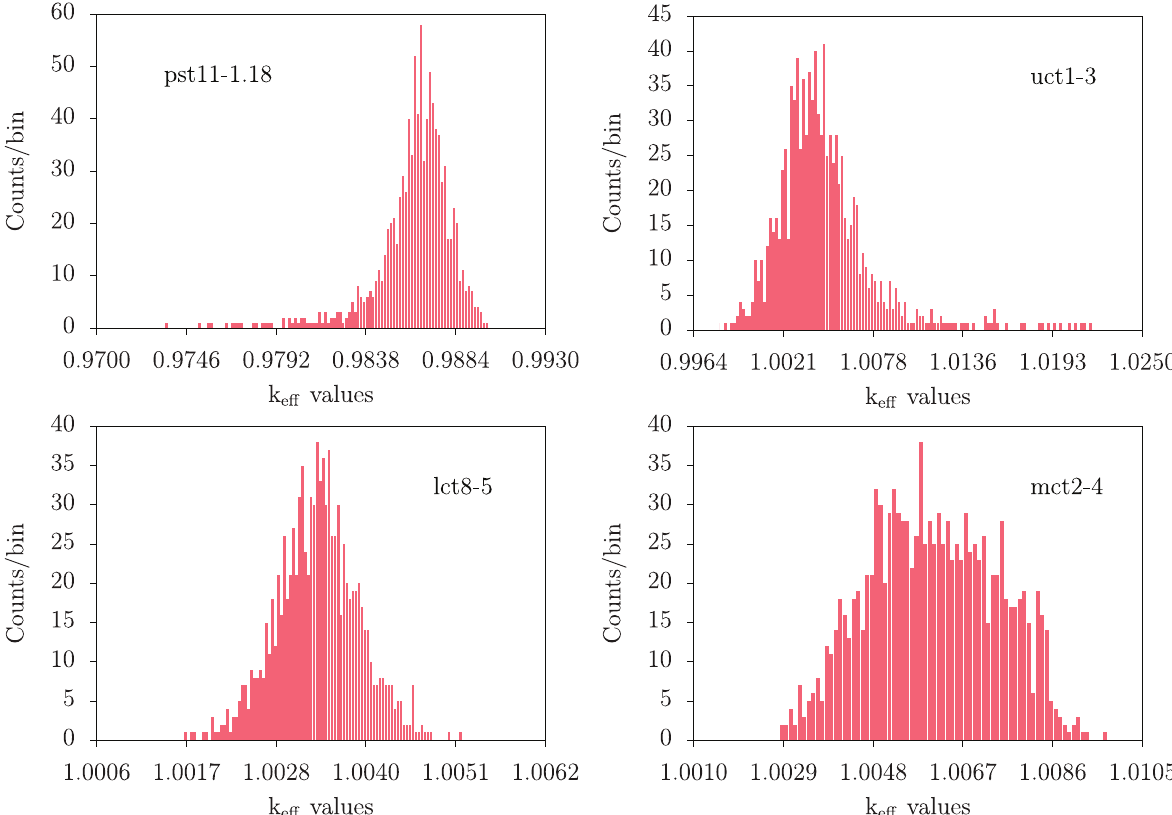
Fig. 1. Probability density function for a number of criticality benchmarks, obtained by randomly changing the H in H 2 O thermal scattering data.